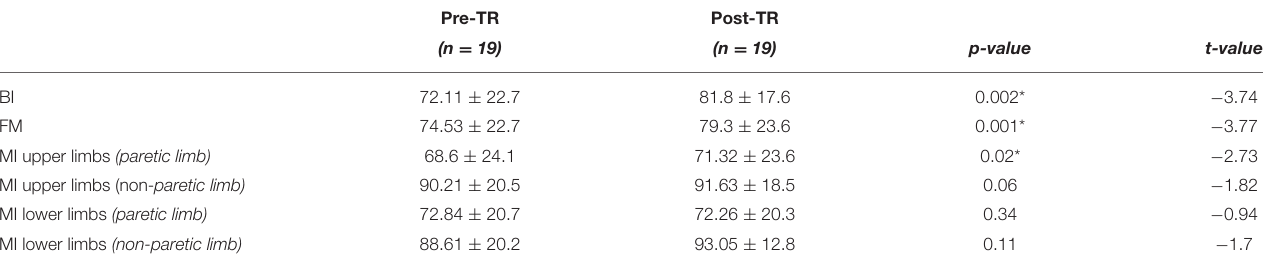
TABLE 2 | Clinical improvements within post-stroke patients before (pre-) and after the (post-) TR protocol.